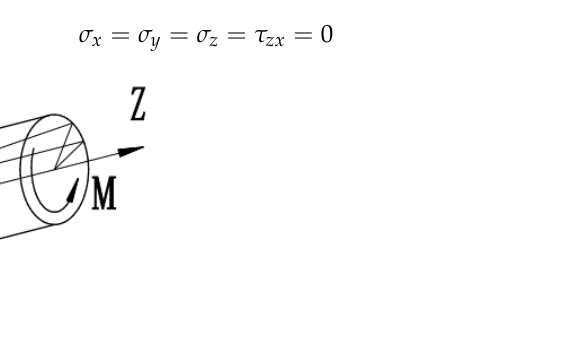
Figure 1. Torsion of bar with equal cross-section.